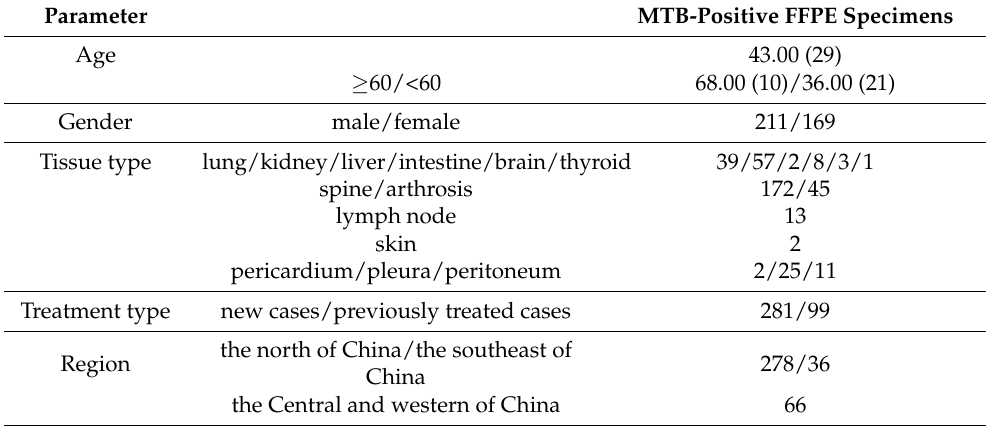
Table 1. Specimen basic